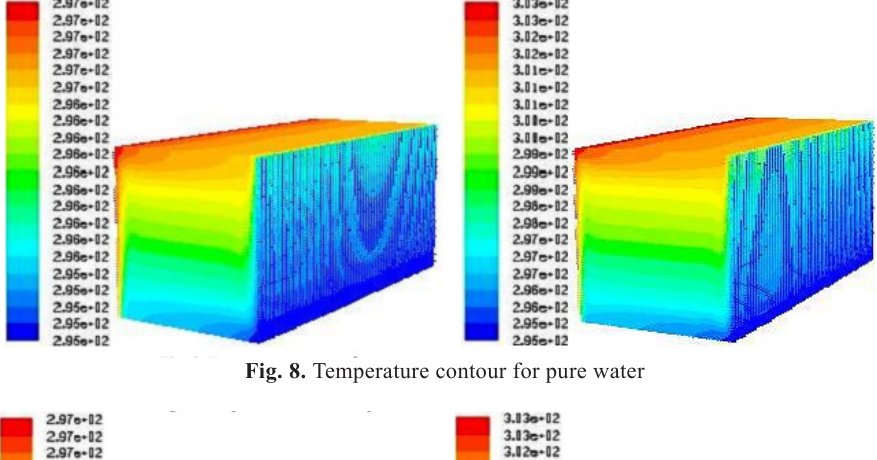
Fig. 8. Temperature contour for pure water